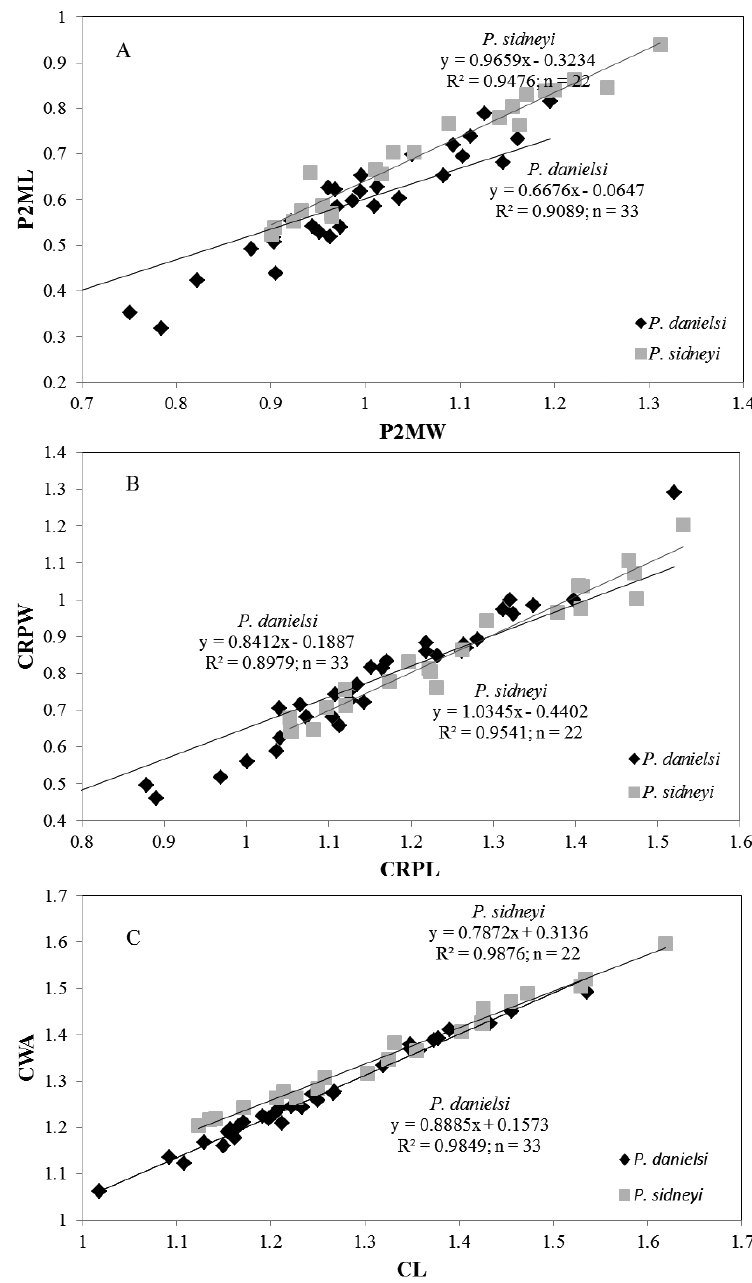
Figure 3. Regression analyses of morphometric measurements of P. danielsi sp. n. and P. sidneyi . Re- gression analyses of: A LogP2ML over LogP2MW B LogCRPW over LogCRPL; and C LogCWA over LogCL between the two species, P. danielsi sp. n. and P. sidneyi . All differences between regressions were statistically significant (p <